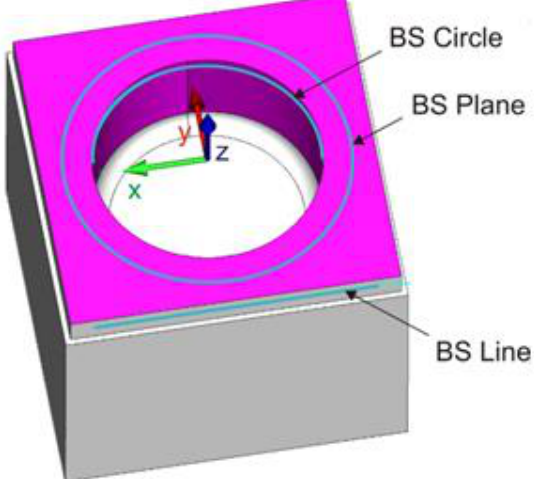
Figure 7. Base system definition.